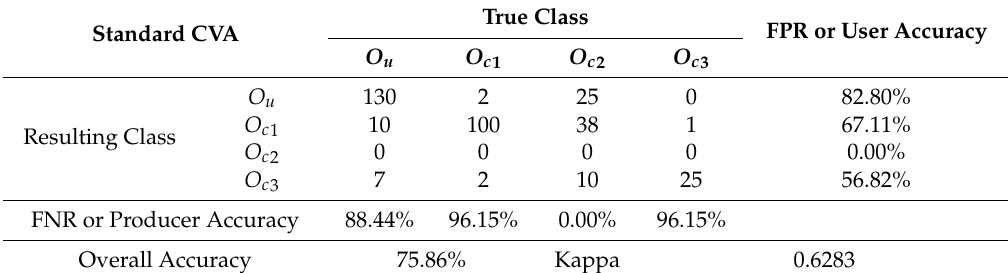
Table 2. The accuracy assessment for the OBCD result obtained by the standard CVA